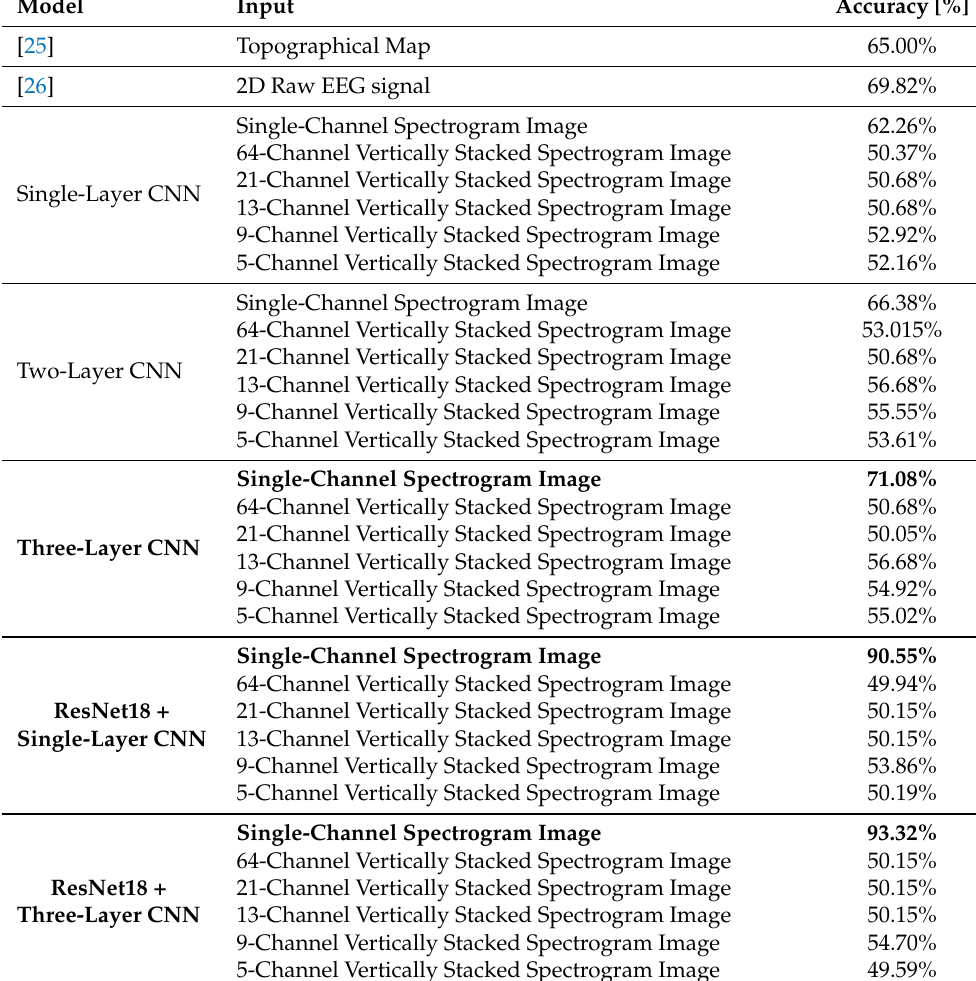
Table 2. Image-based inputs results. The 1-, 2-, and 3-layer simple CNN models returned a test accuracy of 62.26%, 66.38%, and 71.08%, respectively. With the transfer learning implementation, the models returned a test accuracy of 90.55% and 93.32%. In contrast, using vertically stacked spectrograms resulted in a lower classification accuracy, unable to outperform the state of the art. Results that outperformed both studies from the state of the art are in